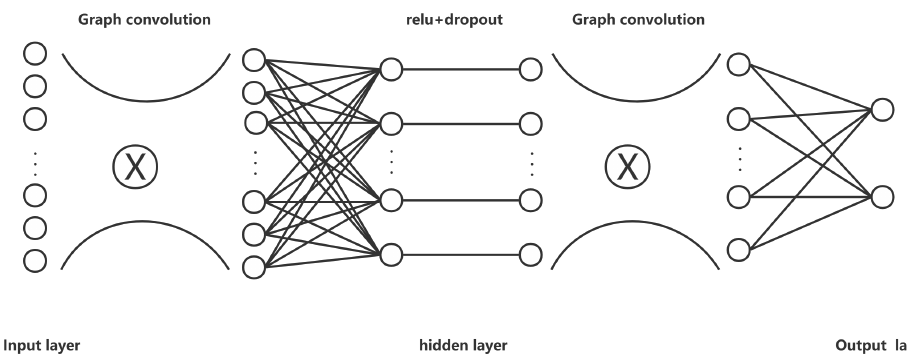
Figure 4. The structure of